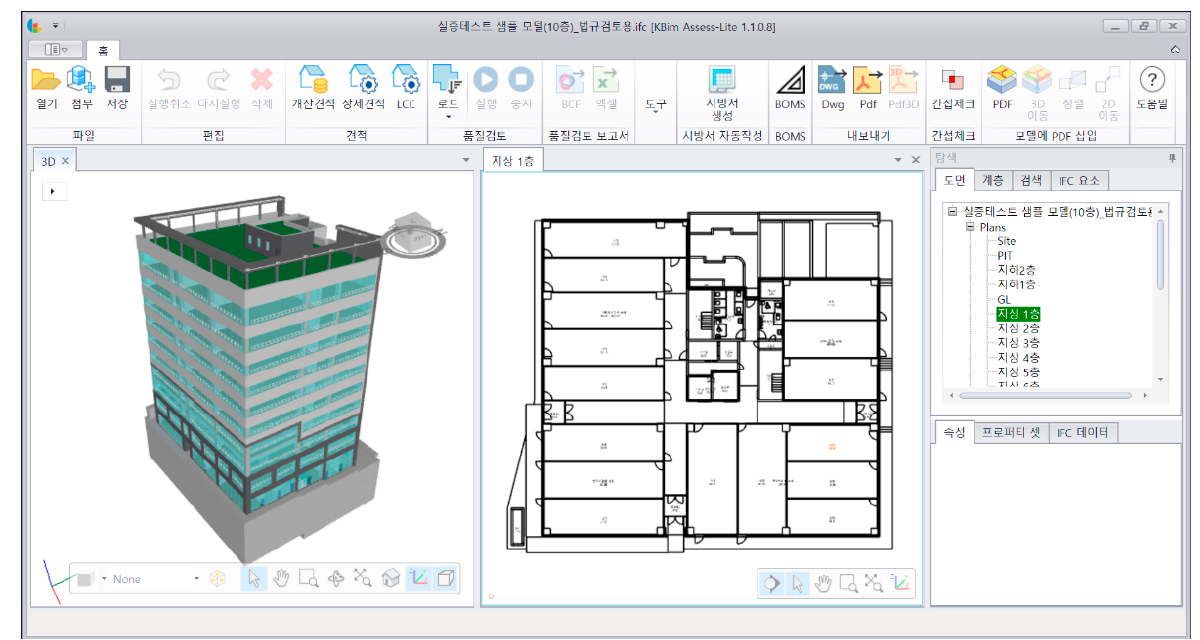
Figure 9. Result converted to IFC.